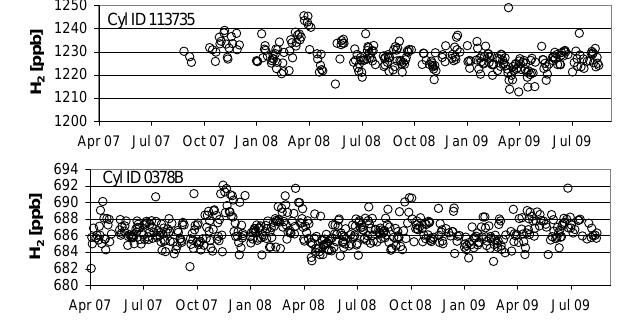
Figure 5. Hydrogen drift rates in air stored in different high pressure cylinder types. The first two bars represent standards stored in Luxfer US aluminium cylinders (US N150 (29 L) purchased from Scott Marrin Inc., Riverside (CA), USA; US N265 (46 L) purchased from Conwin Carbonic Co., Los Angeles (CA), USA); blue and orange bars (UK 20 L and 50 L) represent Luxfer UK aluminium cylinders (purchased from MATAR, Mazzano, Italy); further aluminium cylinders of various origins and sizes are grouped in the red column "alu div"; all steel cylinders tested are presented in the white column. Figure 6. Dependence of H 2 growth rate in air on aluminium cylinder alloy. Symbols represent individual cylinders; black circles refer to the left axis, open symbols refer to the right axis. Data of the cylinder used for the standard mixing procedure (AA7060hw) are illustrated by triangles.